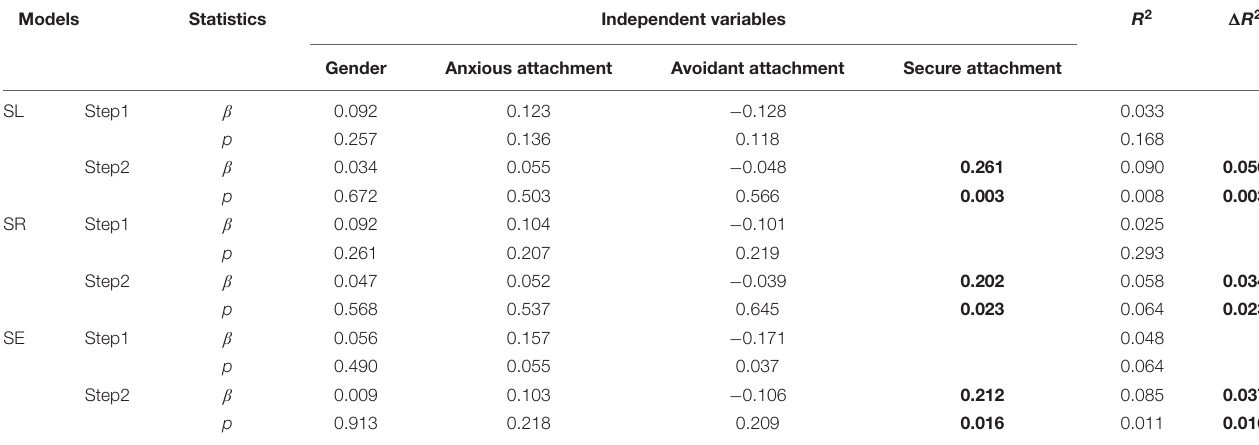
TABLE 5 | Summary of hierarchical regression analyses after attachment priming ( n =